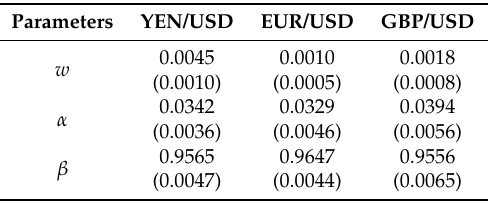
Table 3. QML Estimates of GARCH